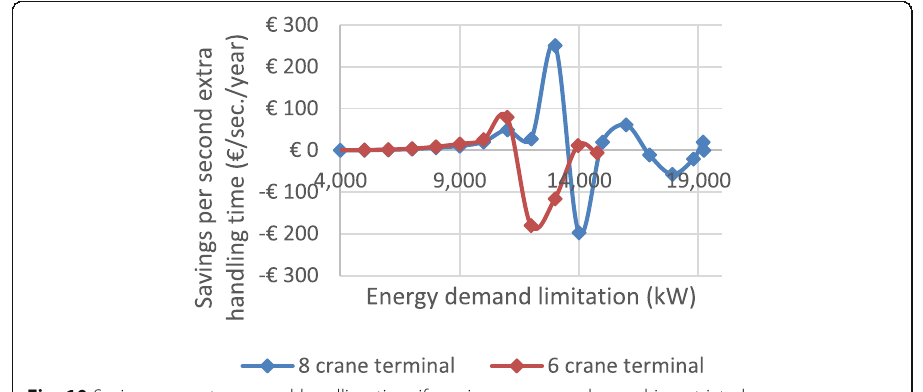
Fig. 10 Savings per extra second handling time if maximum energy demand is